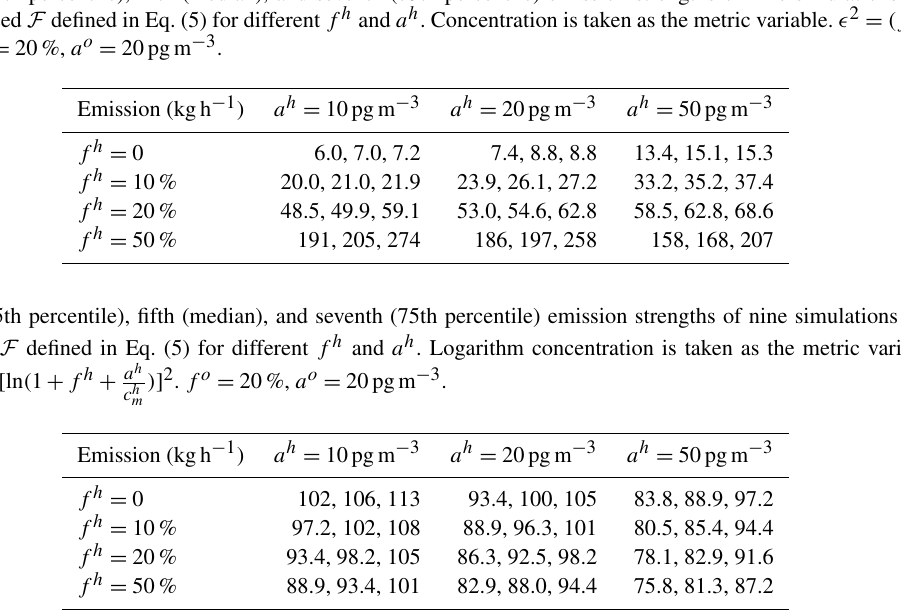
Table 8. The third (25th percentile), fifth (median), and seventh (75th percentile) emission strengths of nine simulations of release 2 that minimize the normalized F defined in Eq. (5) for different f h and a h . Concentration is taken as the metric variable. (cid:15) 2 = (f o × c o + a o ) 2 +